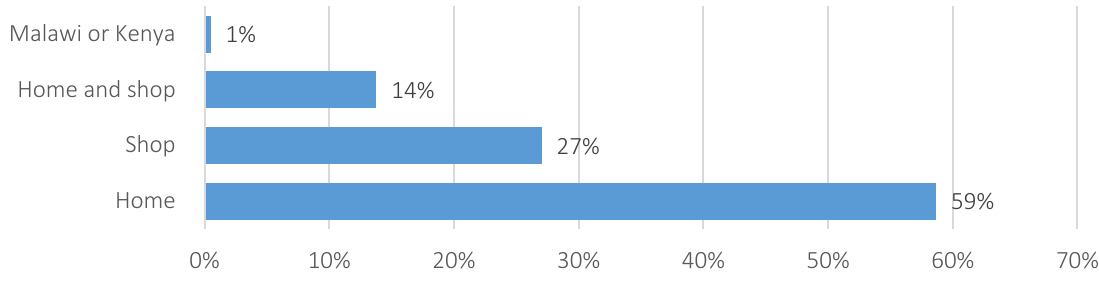
Figure 1. The places of production of artifacts ( n =